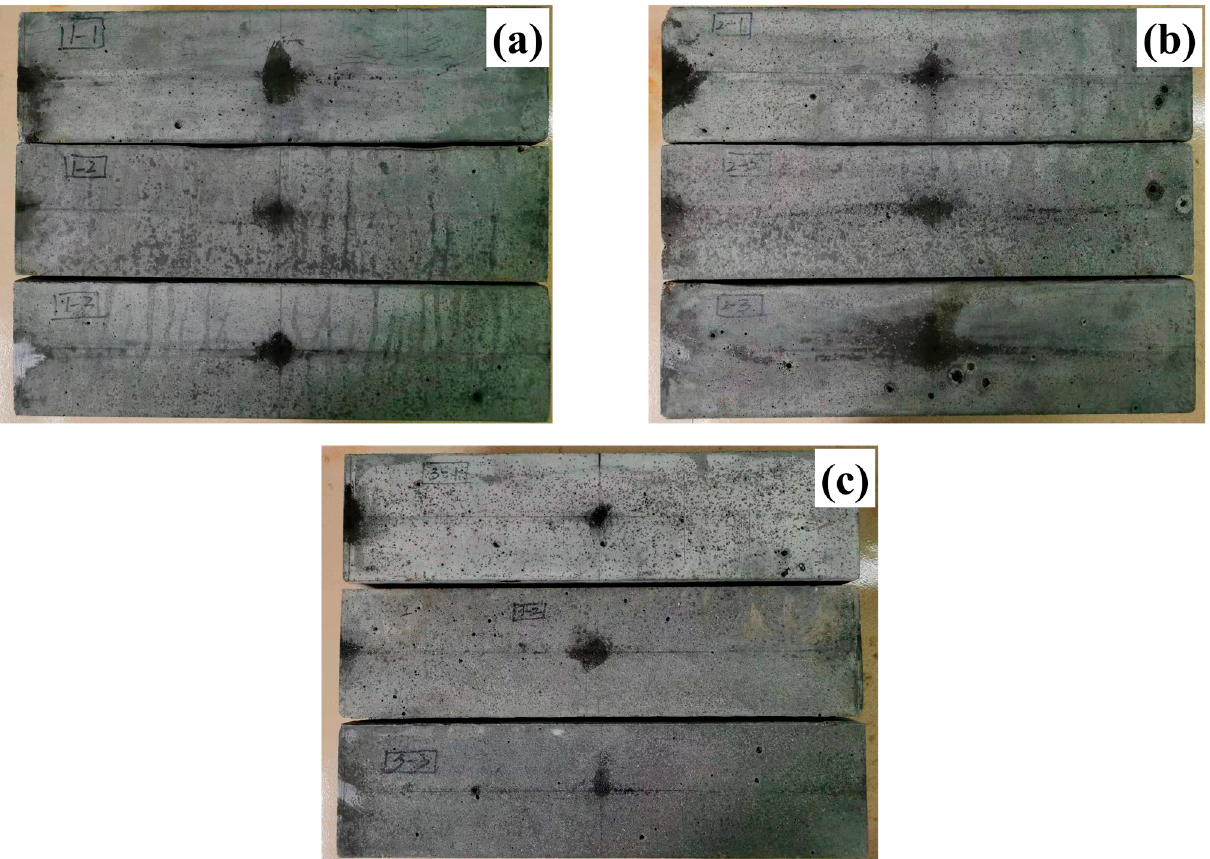
Figure 11. The surface of the UHPC after 500 freeze–thaw cycles: ( a ) CGS-0.7-0.17-2.0; ( b ) CGS-0.8-0.18-2.0; ( c ) CQS-0.7-0.17-2.0.